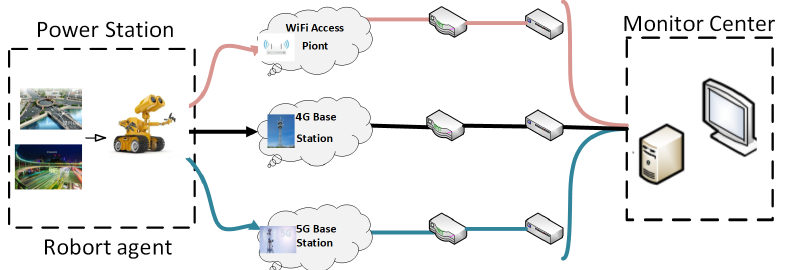
Figure 2. Experimental topology where the inspection robot is connected to the remote server through multiple interfaces for communication.